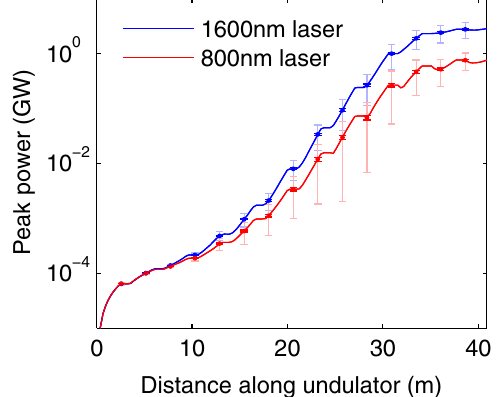
FIG. 3. Power growth along the undulator for the 1600 and 800 nm slicing laser wavelength options. Bold error bars show the error on the mean value; faint error bars show standard deviation over 100 shot-noise seeds.